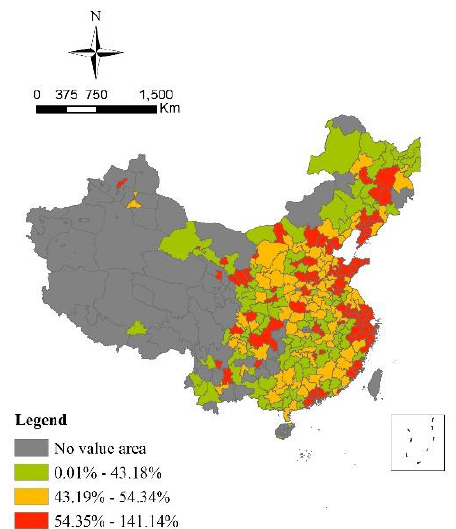
Figure 2. CITRR distribution of Chinese cities.